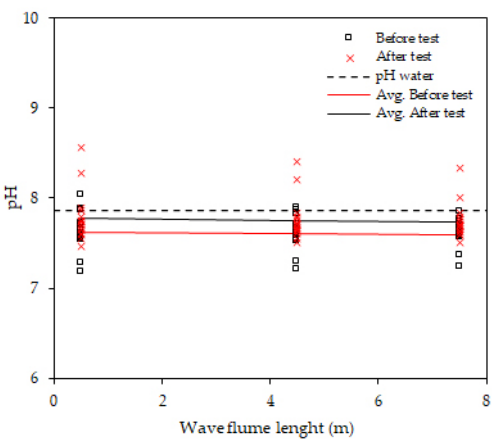
Figure 10. Results of pH measurements.